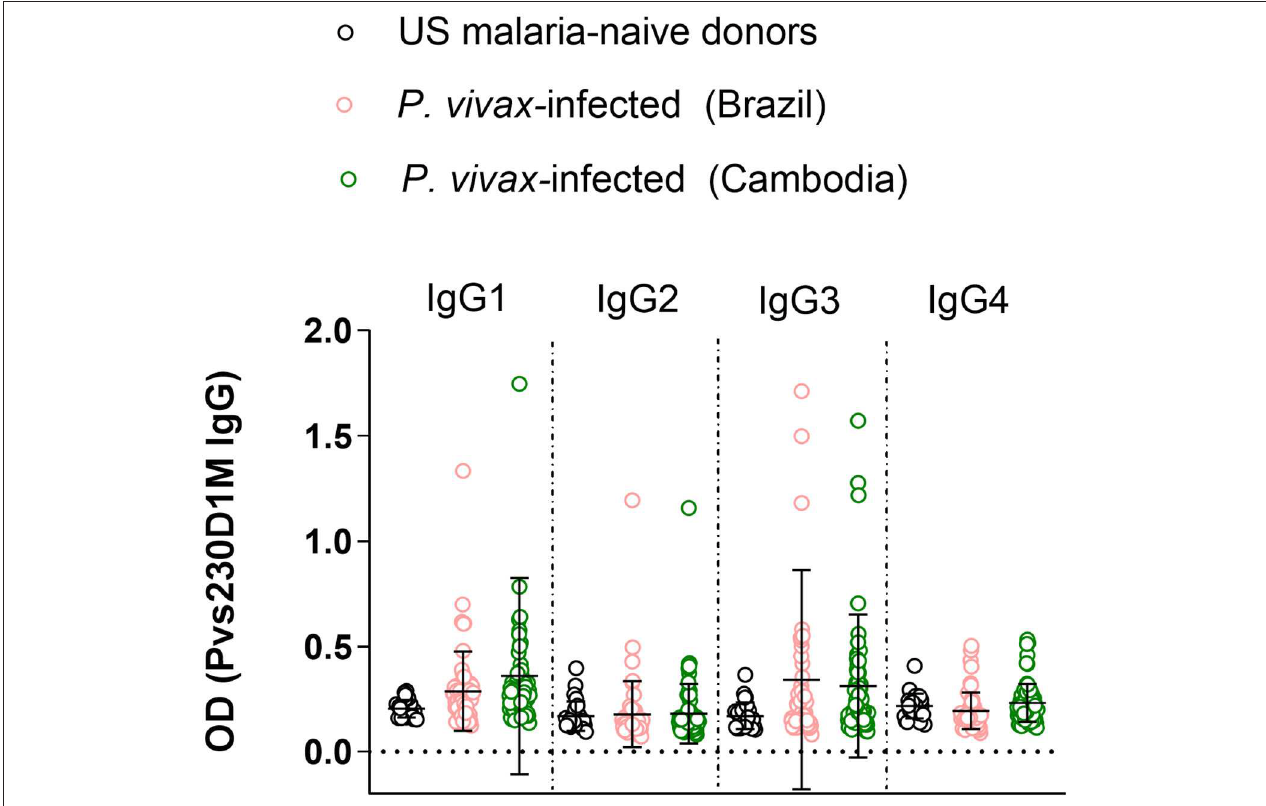
FIGURE 3 | Immunoglobulin G subclass responses to Pvs230D1M in Brazil and Cambodia. Healthy malaria-naïve donor sera were used to define the background for each subclass, and cut-off was calculated based on mean control + 3 standard deviations. IgG3 and IgG1 responses were predominant with limited IgG2 and no IgG4 response. One-Way ANOVA followed by multiple comparisons was used for this analysis and results are displayed as mean ±